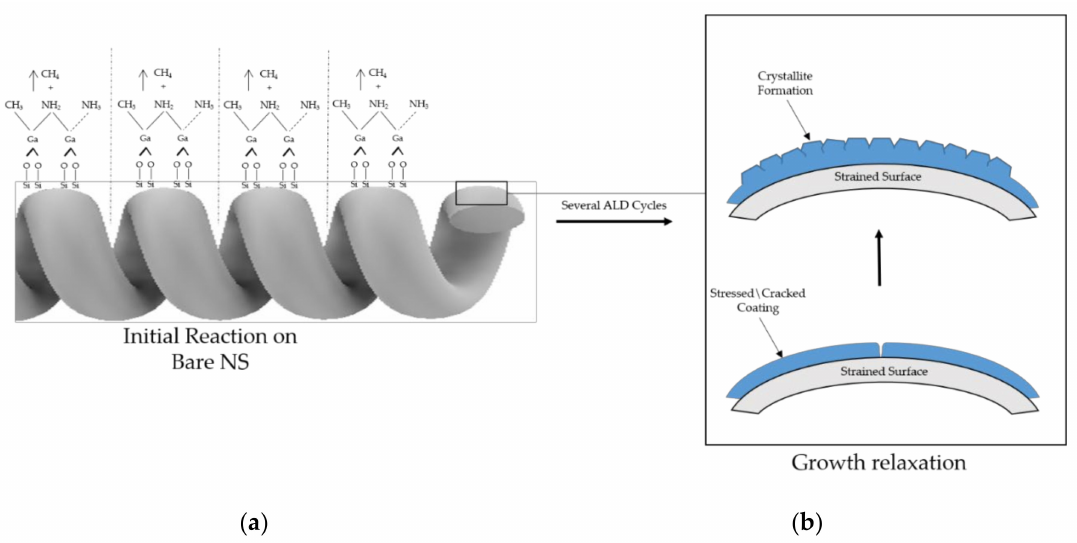
Figure 8. ( a ) Initial surface reaction trimethylgallium (TMG) with the bare NS, where Ga bonds to O sites on the surface of the NS and releases methane byproducts and ( b ) a schematic representation of GaN growth on the strained NS surface, where crystallite growth emerges concomitant with the release of internal